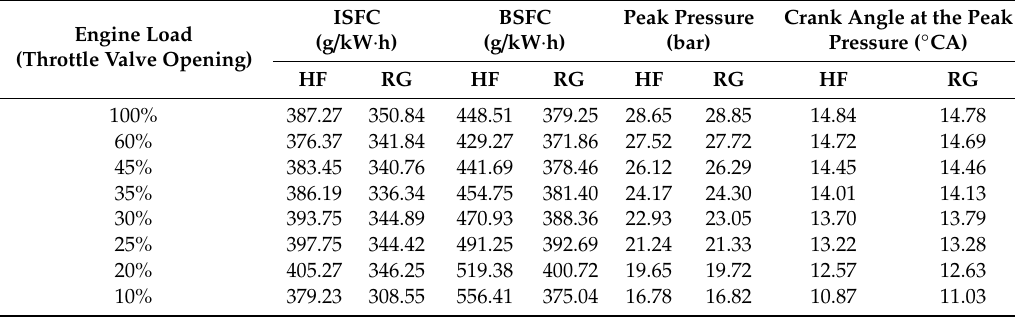
Table 20. Simulation results of engine load characteristics (engine speed = 6500 r /